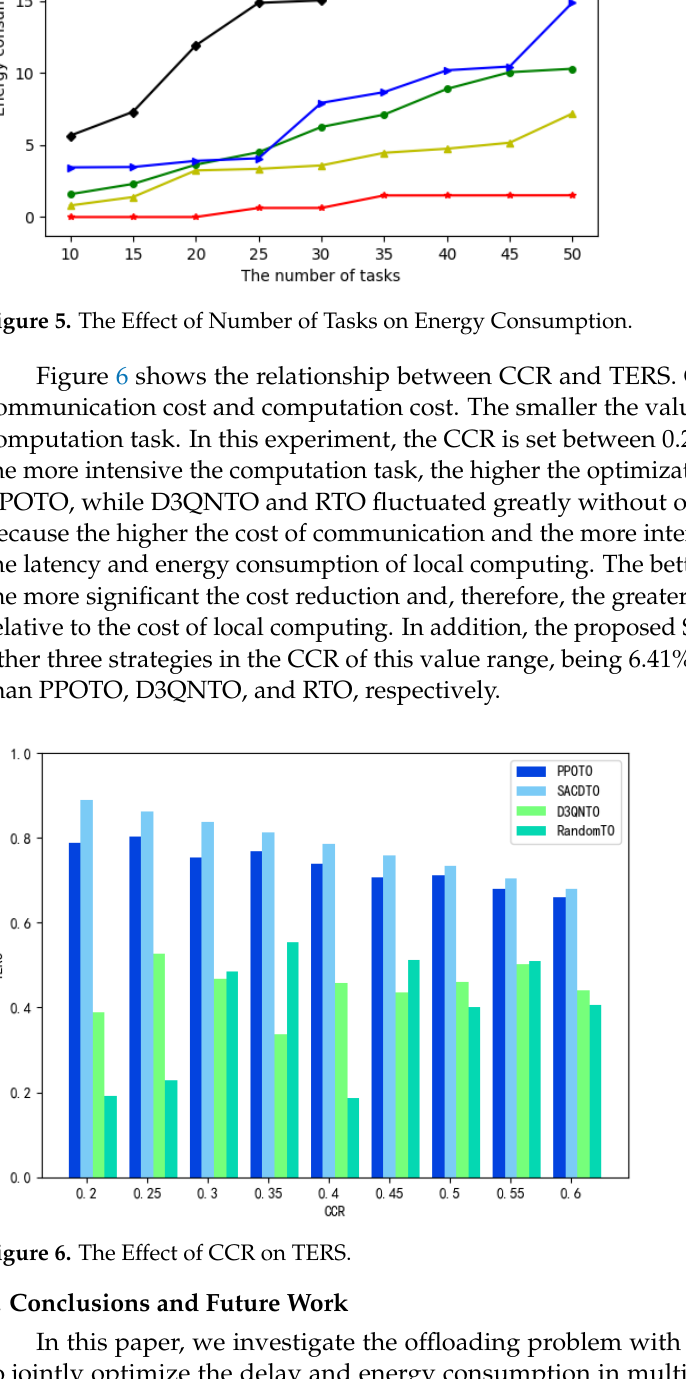
Figure 4. The Effect of Number of Tasks on Delay.